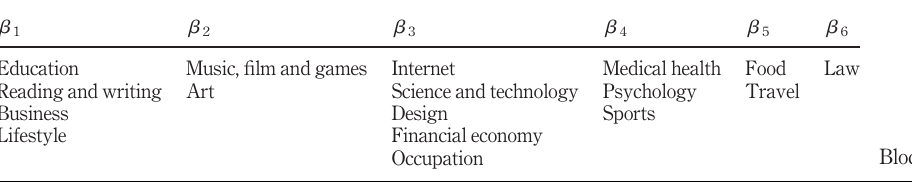
Table 2. Block model statuses